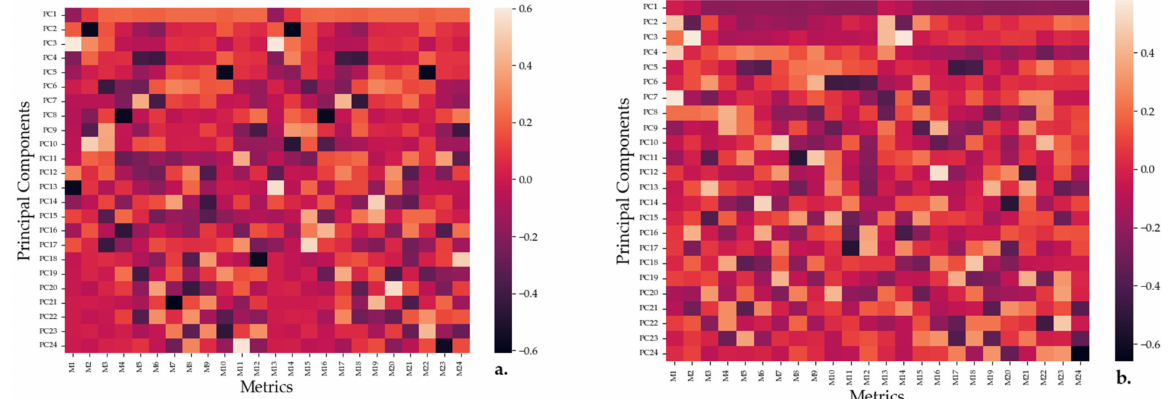
Figure 9. Feature maps representing the correlation between the information explained by the PCs approximated by PCA and the metrics/features collected while interrogating the SAu/AgNP-WT samples. A diagram of how each set of 12 features for a single wavelength is collected is given in Figure S5. ( a ) Feature map for the single wavelength measurements with M1 to M3 representing the blank, positive blank and negative blank responses and M4 to M12 representing a sequence of three repeats of each dilution measurement when the samples were interrogated with light at 562 nm. Similarly, M13–M24 express the absorbances of the samples when measured using 600 nm light. ( b ) Feature map for the multi-wavelength measurements with M1 to M3 representing the blank, positive blank and negative blank responses and M4 to M12 representing a sequence of three repeats of each dilution measurement when the samples were interrogated under fluorescence